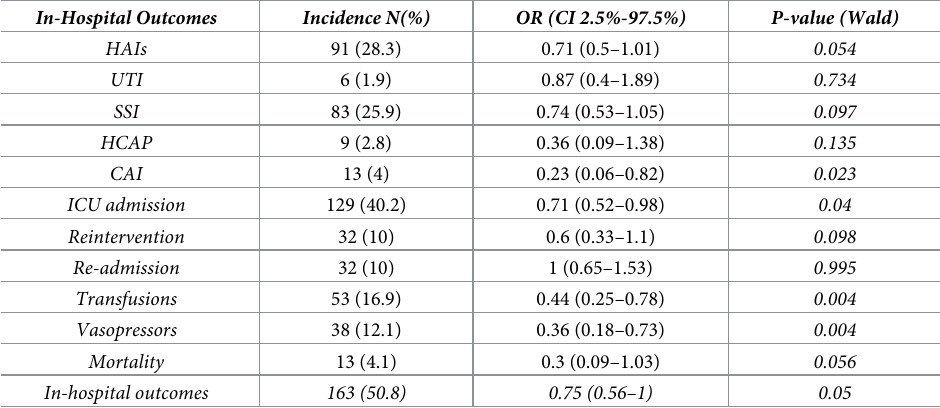
Table 3. Associations between serum vitamin D concentration and In-Hospital outcomes.